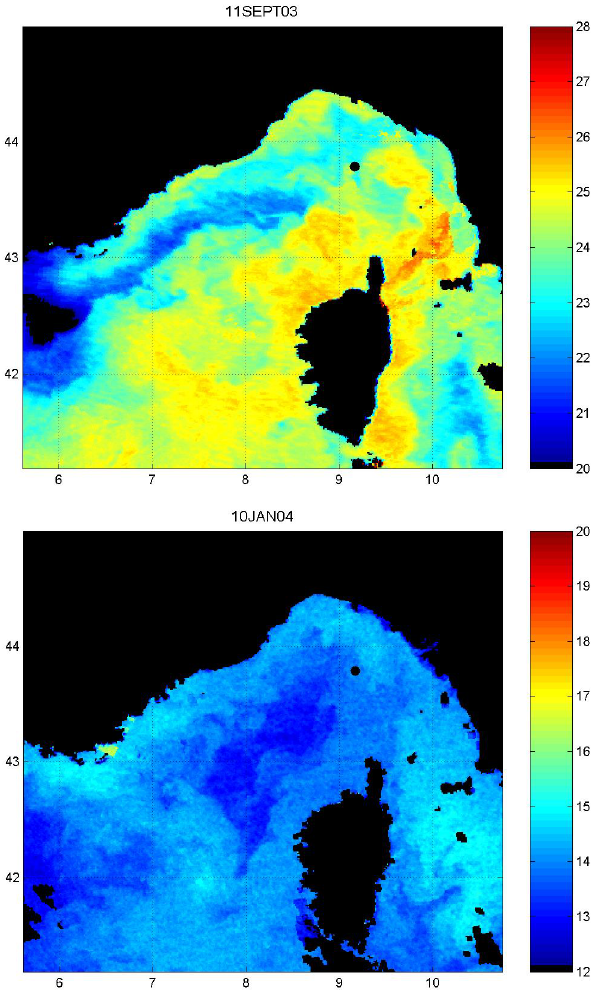
Fig. 4. SST images of the Ligurian Sea taken on 11th of September 2003 (a) and 10th of January 2004 (b) . The image of September clearly evidences the front separating the peripheral coastal water from the water of the central zone. Winter SST indicates an en- hancement of the cyclonic gyre, with colder waters in the central part. Big dot indicates the ODAS Buoy location.